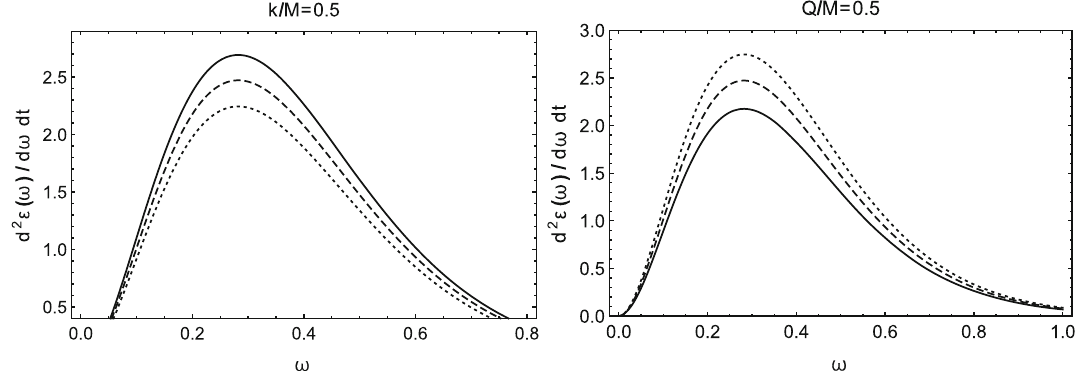
Fig. 7 Energy emission of the black hole for distinct charge and plasma parameters. In the left panel the solid, dashed and dotted plots correspond to Q / M = 0, 0.5 and 0.7, respectively. In the right panel the solid, dashed and dotted plots correspond to k / M = 0, 0.5 and 0.7,